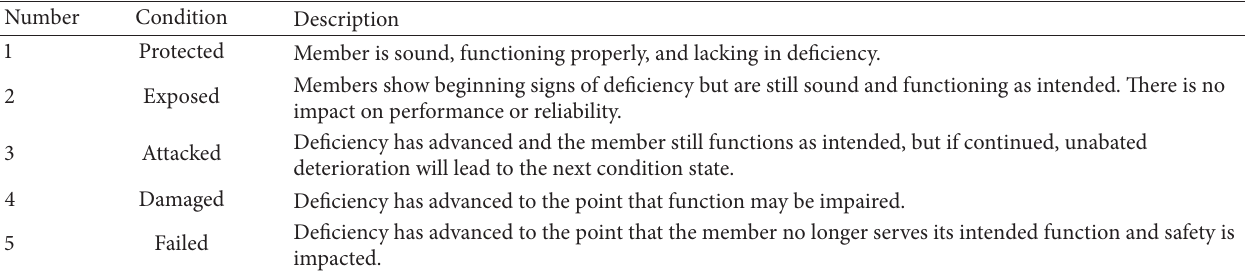
Table 1: Five condition states.